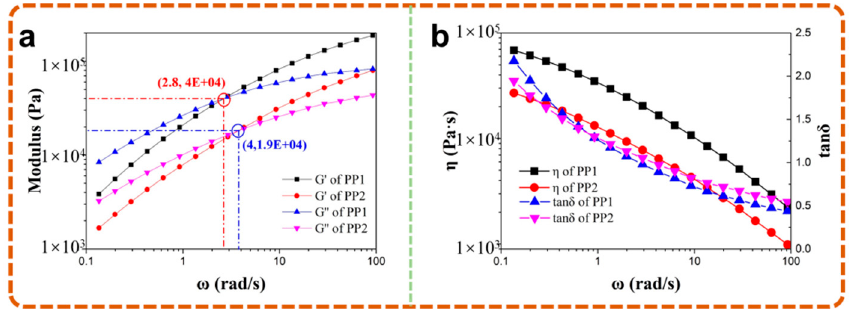
Figure 7. Modulus ( a ), complex viscosity and loss tangent ( b ) of materials. Table 2. Angular frequency ( ω ) and storage modulus (G ‘) at the intersection of modulus curves. Sample